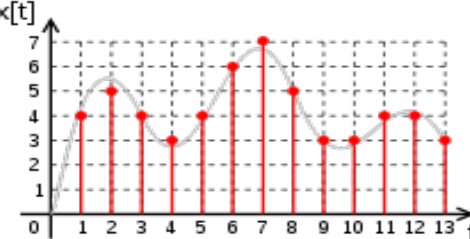
Figure 1. Example of analog and digital